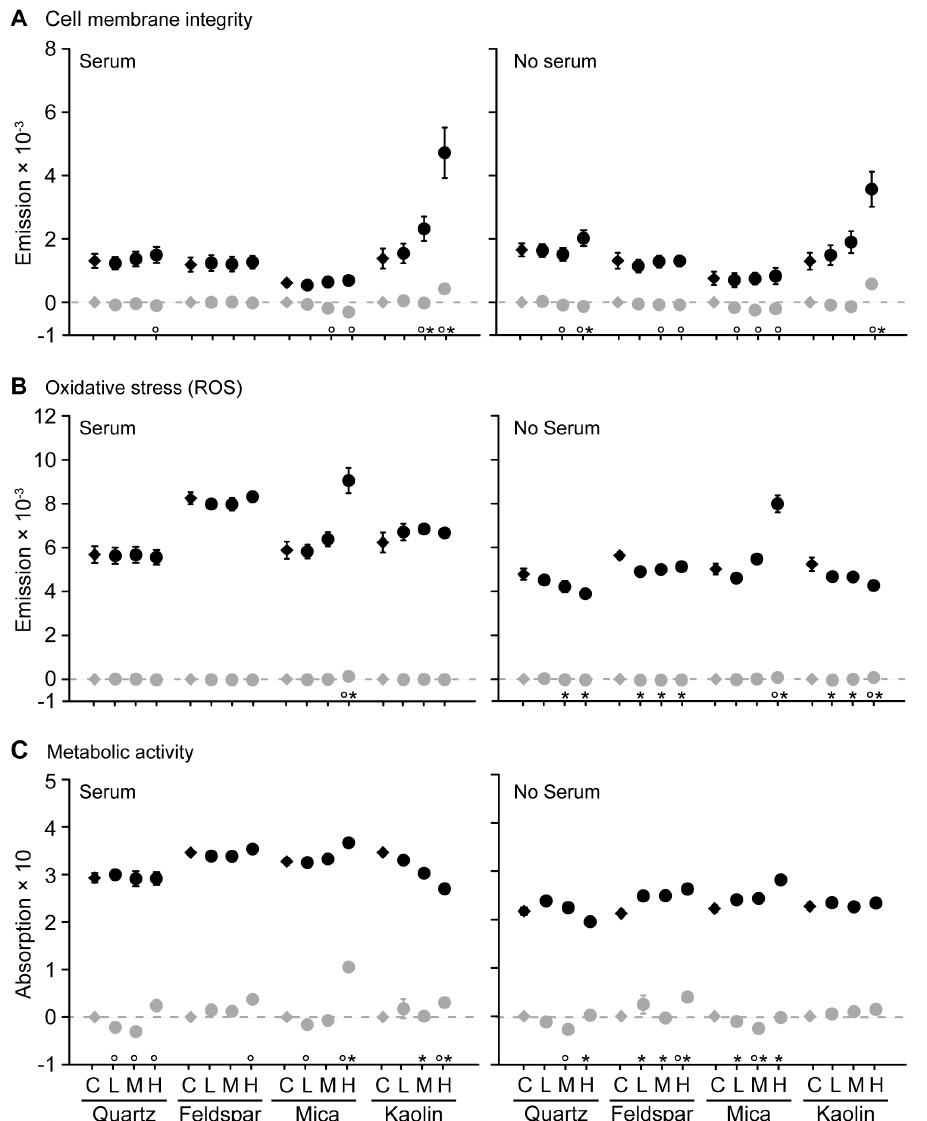
Figure 2. Cytotoxic effects and particle interference in the applied cytotoxicity assays. Shown are cytotoxic effects of the particles in cells (black symbols) and particle interference with the respective assay (grey symbols), all data after 72 h exposure. Symbols near the x-axis denote significant differences (p , 0.05) to respective control for cytotoxicity (asterisks) and particle interference (circles) data. Labels on x-axis denote control (C, no particles), as well as low (L, 10 mg L 2 1 ), medium (M, 50 mg L 2 1 ) and high (H, 250 mg L 2 1 ) treatment level, grouped according to mineral species. Data points are mean 6 SE. Note: Shown are summary statistics calculated from raw-data, while significance was tested with linear mixed- effect models to adjust for clustering of the wells on plates.